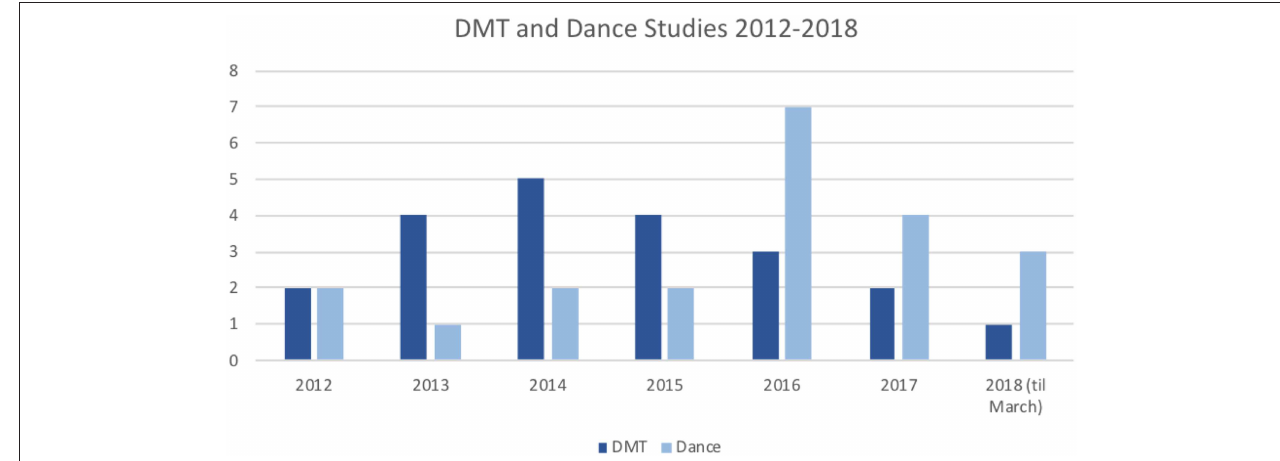
FIGURE 3 | Included studies per year with DMT or dance